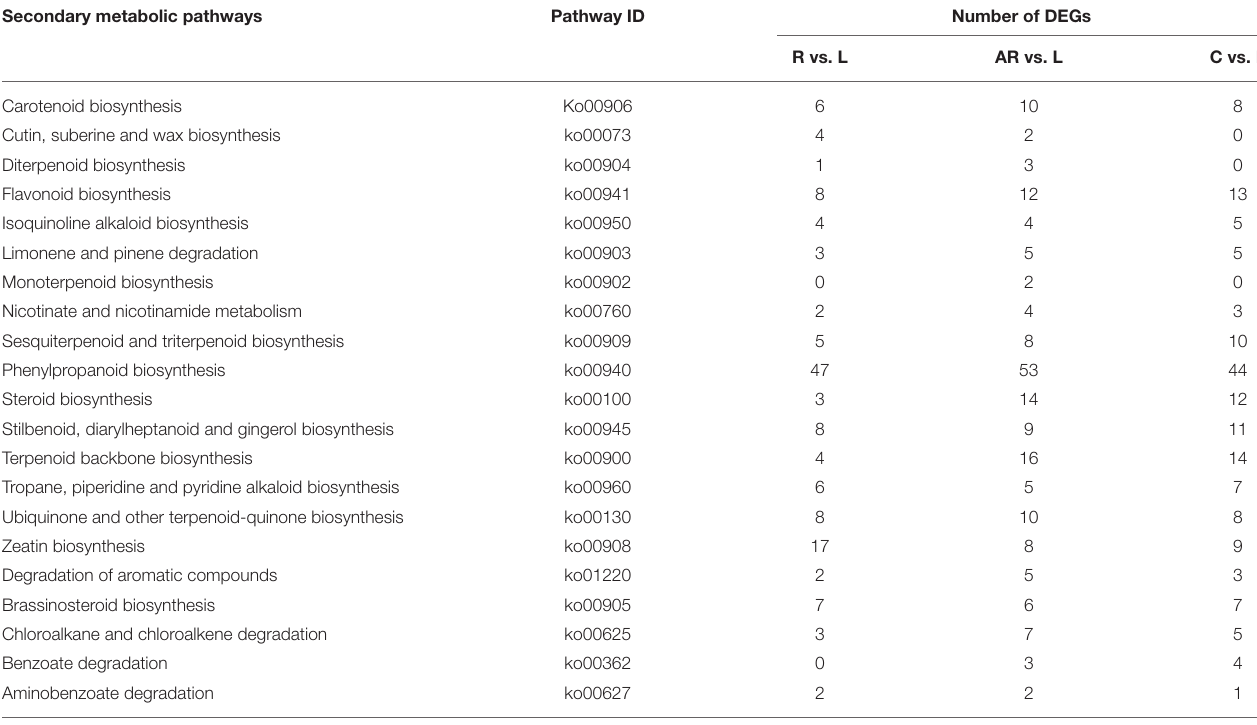
TABLE 3 | Secondary metabolic pathways and their related number of DEGs in the three samples as compared with leaves. Secondary metabolic pathways Pathway